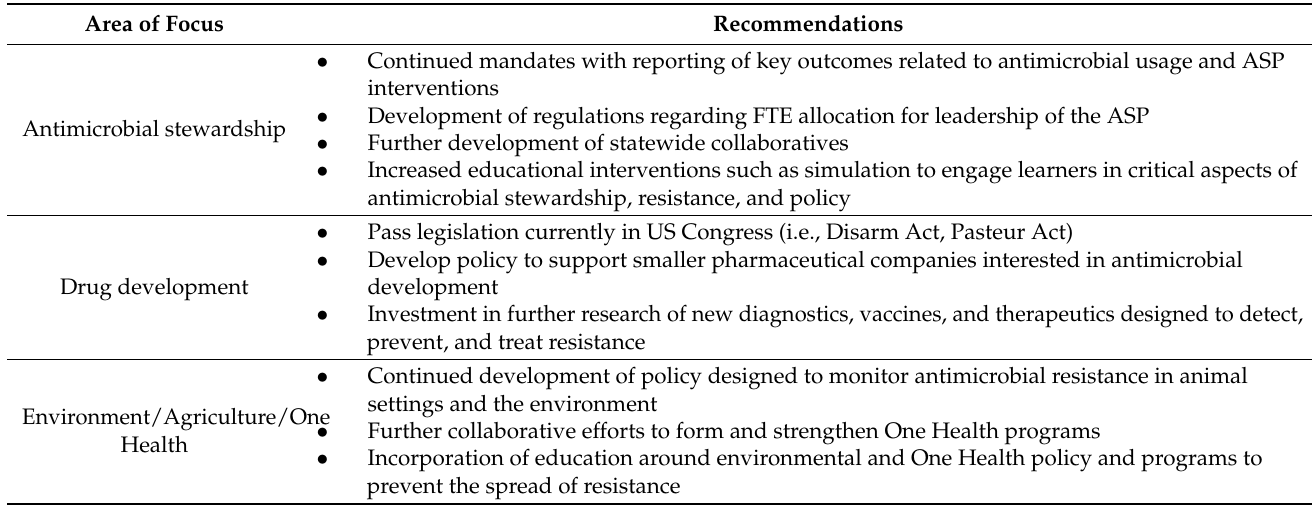
Table 2. Recommendations for comprehensive policy and